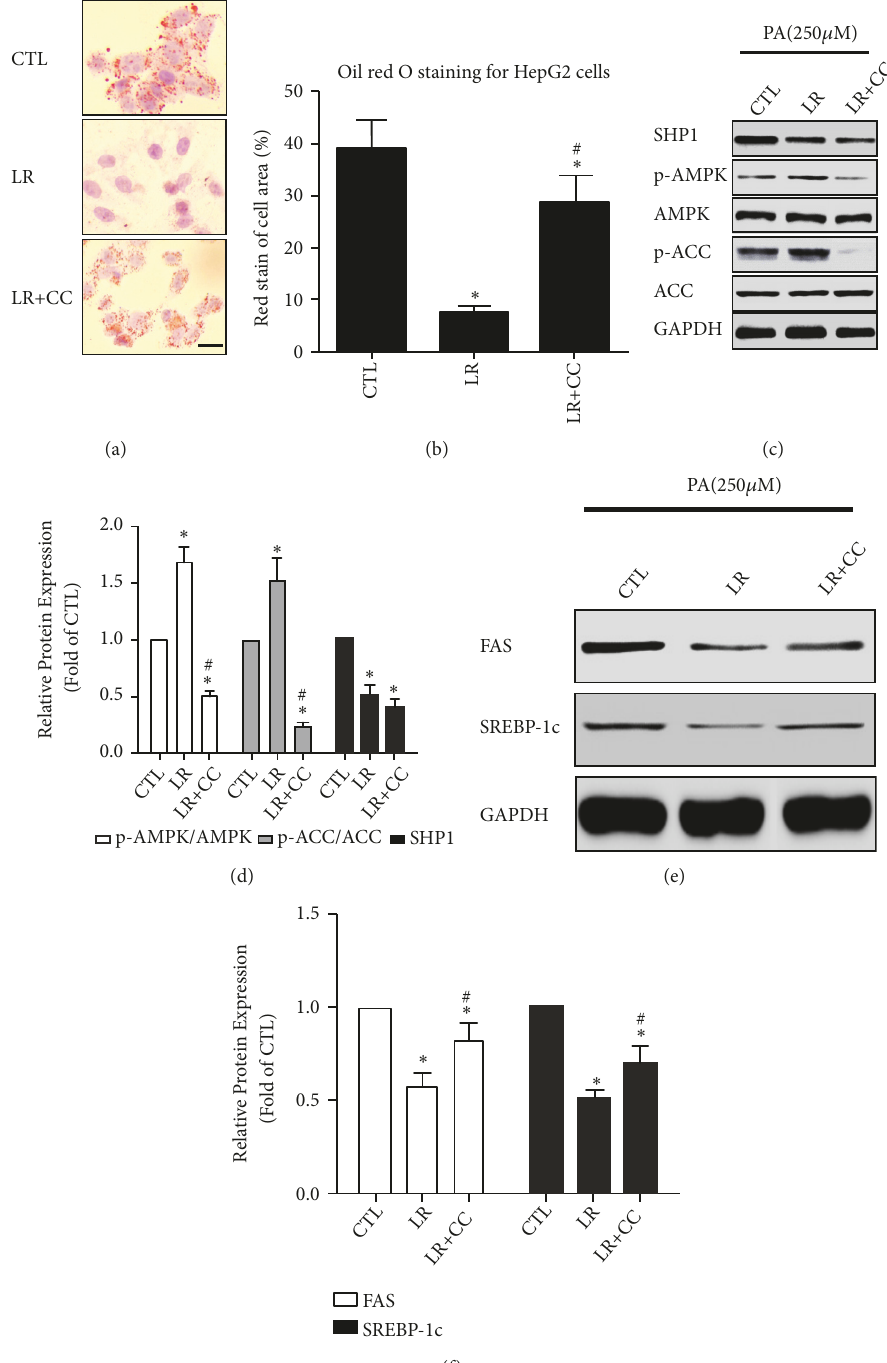
Figure 5: AMPK inhibitor could block liraglutide induced reduction of lipid lipogenesis and without change on SHP1 expression . (a) HepG2 cells were cultured in FBS-free DMEM and then subjected to 250 nmol/L PA in 24 hours and exposed to indicated drugs for 4 hours. And cells were stained with Oil Red O and photographed under the microscope (magnification × 200, scale 20 𝜇 m). (b) Intracellular lipid accumulation was quantified by semiquantitative analysis. The rate of cell with positive area is shown as mean ± SD of three independent experiments. (c, d) Effect of AMPK inhibitor compound C (CC) on protein expression of SHP1, p-AMPK, AMPK, p-ACC, and ACC in vitro . The densitometry ratio of SHP1/GAPDH, p-AMPK/AMPK, and p-ACC/ACC are shown as mean ± SD of three independent experiments. (e, f) Effect of CC on protein expression of lipogenesis proteins (FAS and SREBP-1c) in vitro . The densitometry ratio of FAS/GAPDH and SREBP-1c/GAPDH is shown as mean ± SD of three independent experiments. Whole-cell protein was harvest and detected by western blot. The representative images are shown. The western blot results were normalized to the CTL group value. ∗ denotes P < 0.05 versus the CTL group. # denotes P < 0.05 versus the LR